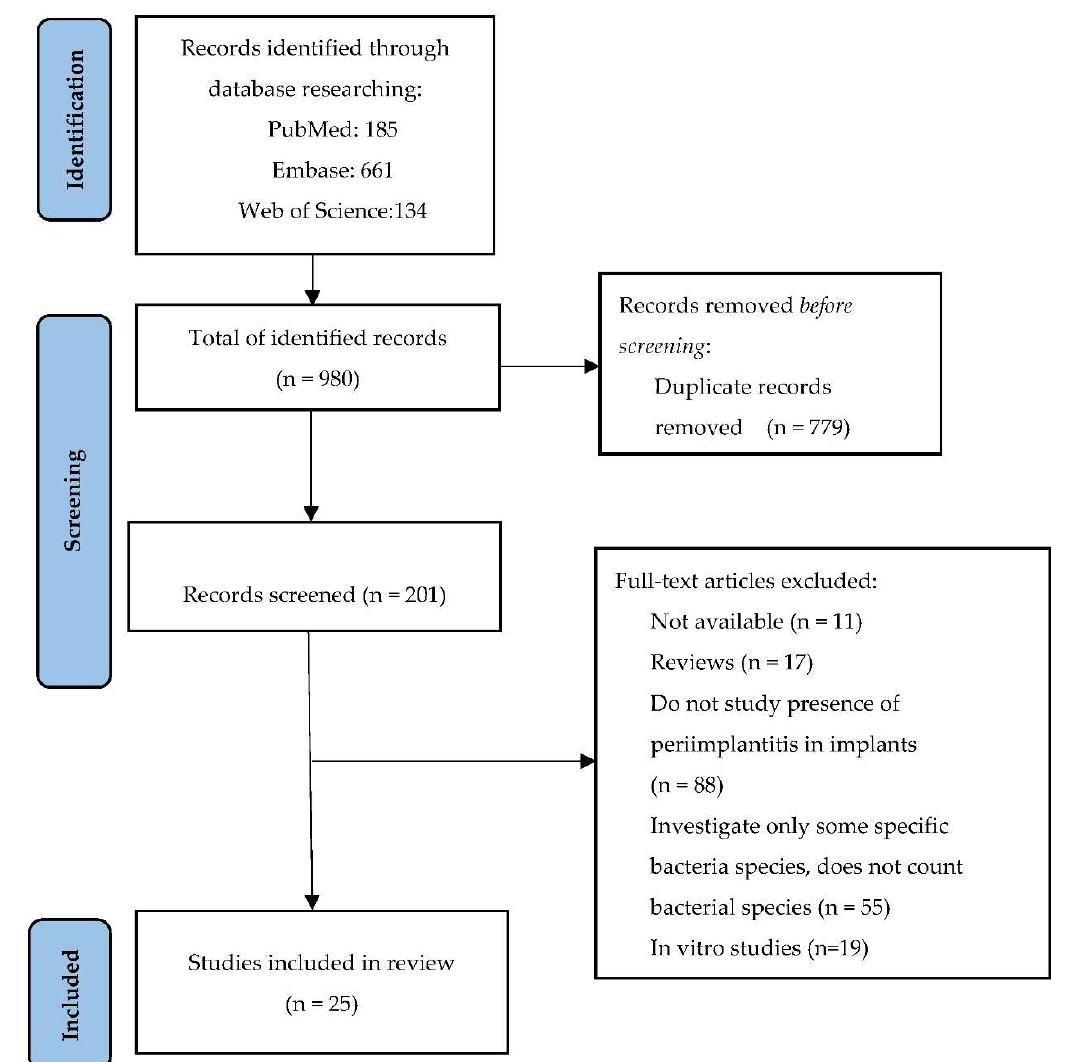
Figure 1. PRISMA flow diagram. Study selection for review.